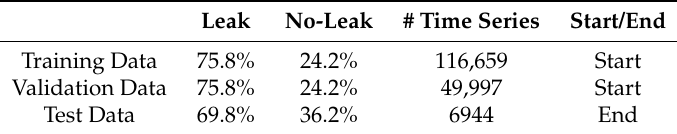
Figure 1. ( a ) FVCOM domain used in which resolution varies from 15 km at the open boundaries to 0.5 km at the release site. The black box indicates the extents of the grid shown in ( b ). ( b ) The nested domain with resolution from 0.5 km at the boundary to 3 m at the release site (red star). The black box in ( b ) indicates the extent of the Goldeneye complex [56]. Table 1. Overview of the train, validation and test